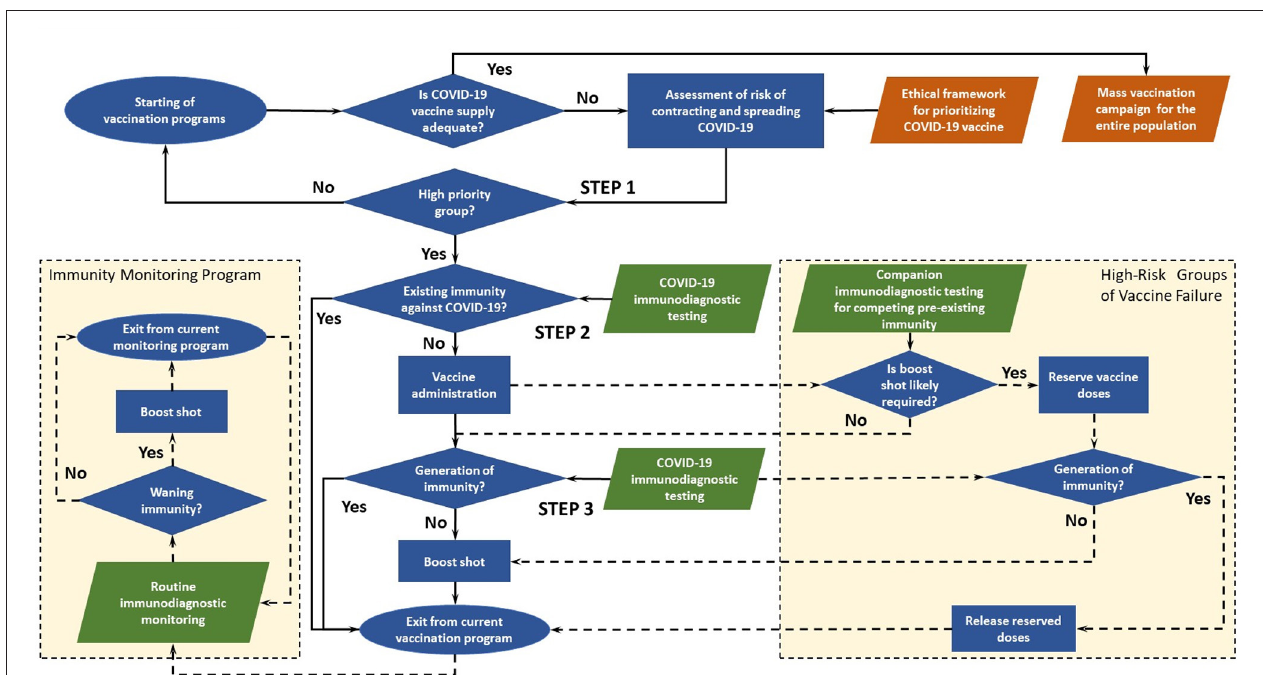
FIGURE 1 | Decision-making flowchart for immuno-triaging of COVID-19